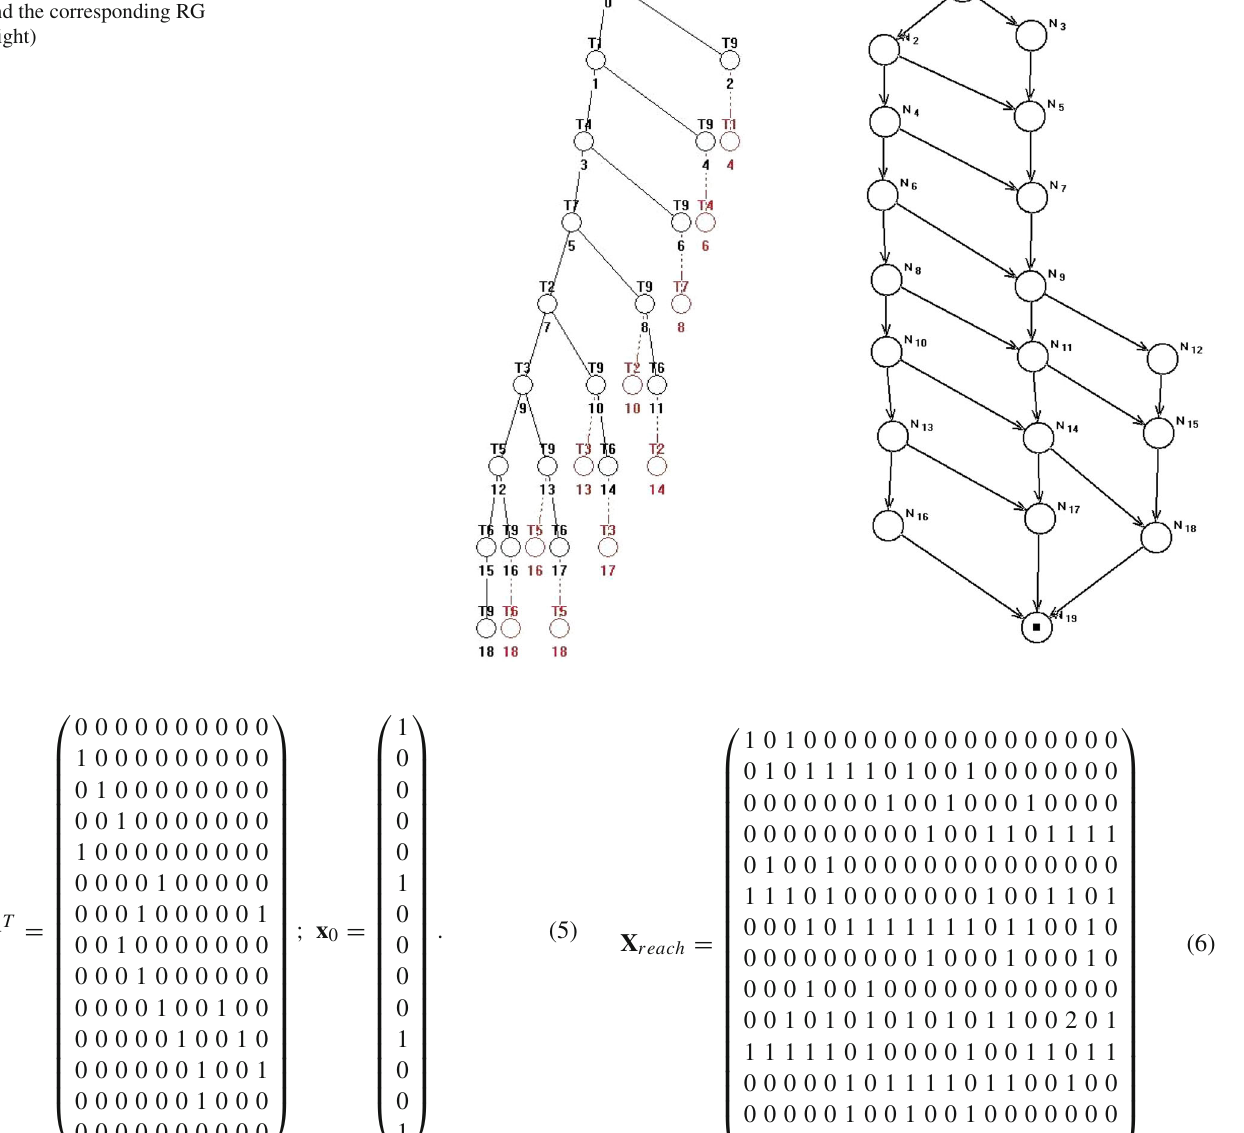
Fig. 5 The RT of the system with the finite number (namely only once in this case) of possible occurrences of the failure represented by t f and the corresponding RG